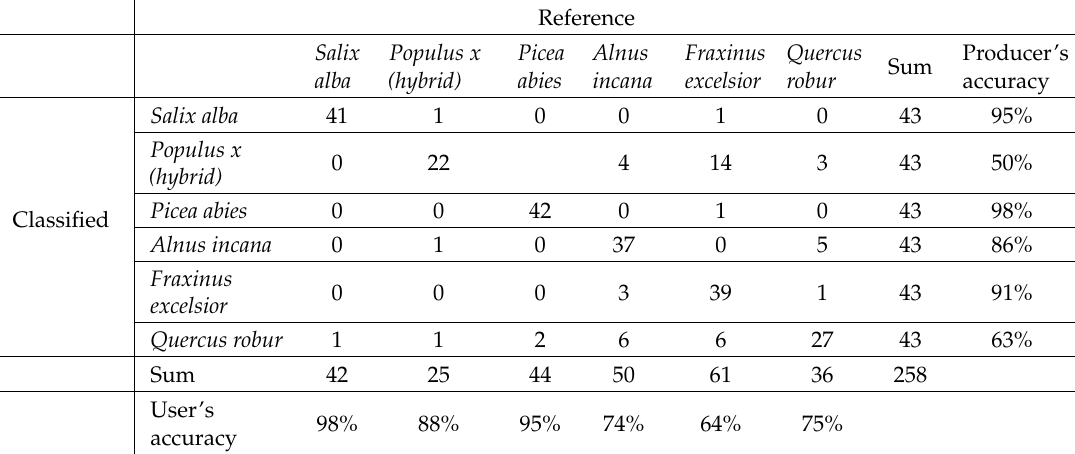
Table A1. The accuracy assessment using the APEX hyperspectral imagery with all the 268 spectral bands as an input to the RF algorithm.